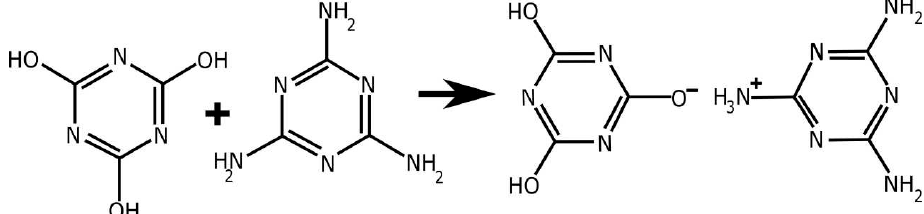
Figure 2. The insoluble complex that is formed by the reaction of isocyanuric acid and melamine.